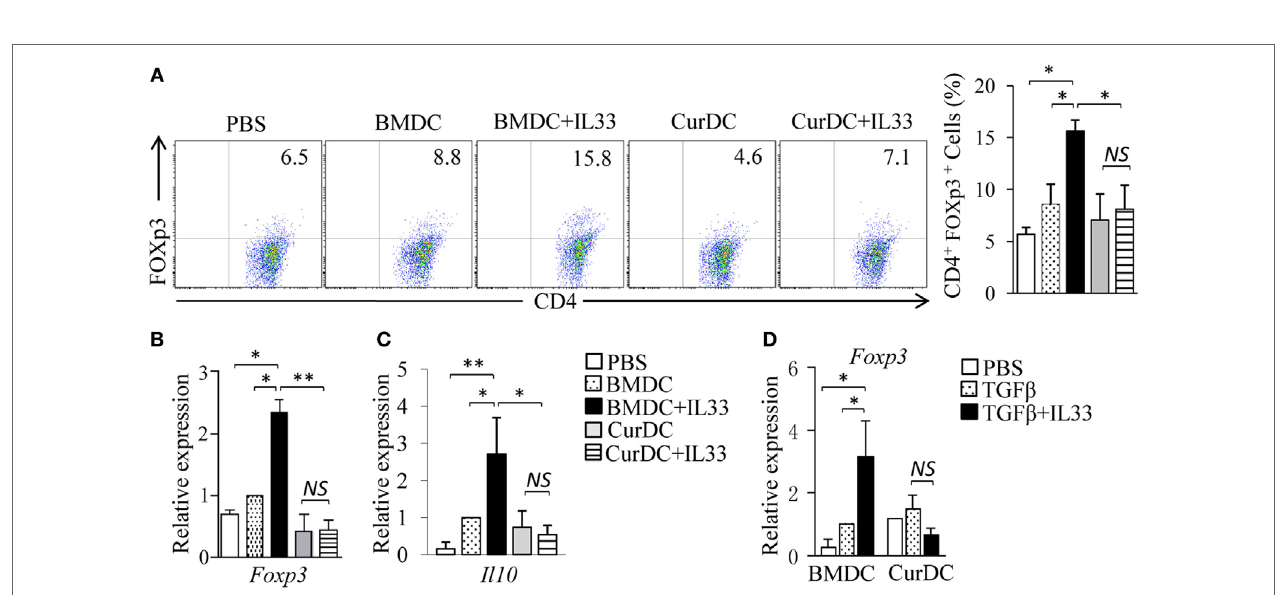
FigUre 5 | The role of interleukin (IL)-33 in dendritic cell (DC)-induced regulatory T (Treg) differentiation. (a–c) OT-II mice (two to three mice/group) were immunized twice (1 week apart) with OVA-peptide-pulsed BMDCs or CurDCs. In addition, some of the mice immunized with BMDCs or CurDCs were given IL-33 (250